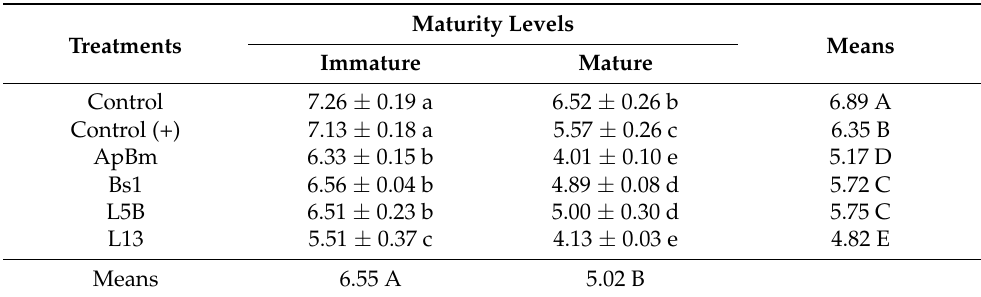
Table 2. Effect of endophytic bacteria inoculation on mean germination times of immature and mature pepper